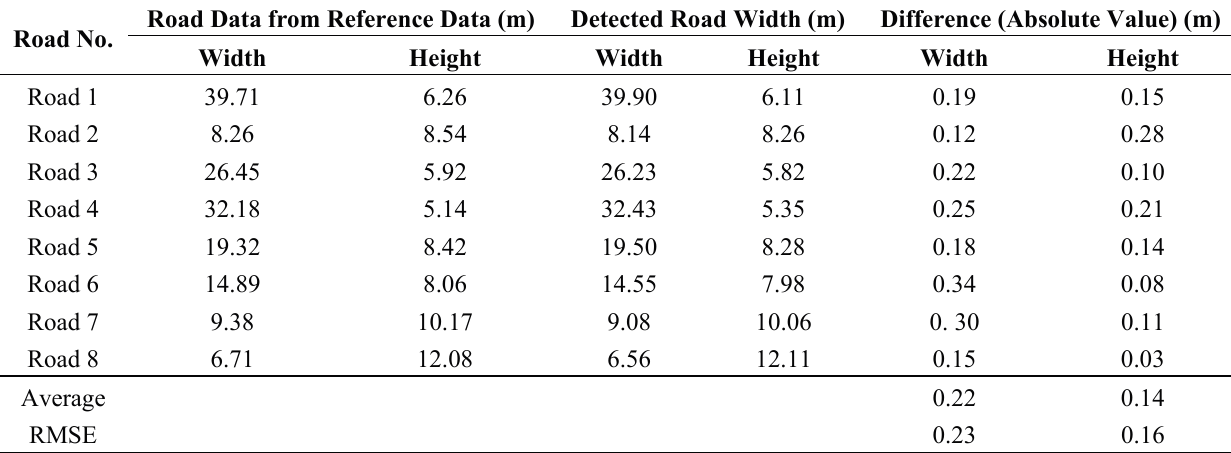
Table 4. Road width and height accuracy